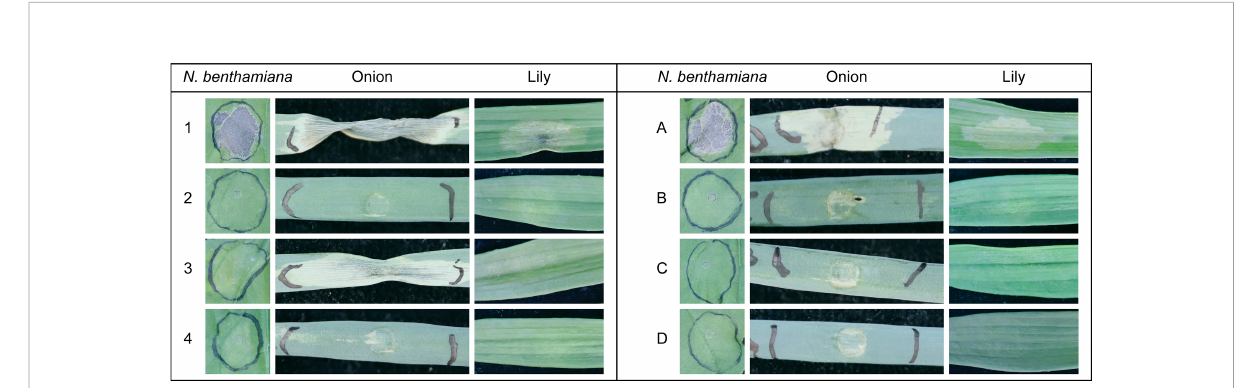
FIGURE 3 Leaf responses observed at 3dpi caused by in fi ltration of crude CF samples (left panel) and AS precipitated compounds (right panel) obtained from liquid cultures of B. squamosa and B. elliptica on leaves of N. benthamiana , onion and lily. 1 = B. elliptica grown in GB5_lily; 2 = B. elliptica grown in GB5_onion; 3 = B. squamosa grown in GB5_lily; 4 = B. squamosa grown in GB5_onion. (A) = AS precipitation of B. elliptica CF grown in GB5_lily; (B) = AS precipitation of B. elliptica CF grown in GB5_onion; (C) = AS precipitation of B. squamosa CF grown in GB5_lily; (D) = AS precipitation of B. squamosa CF grown in